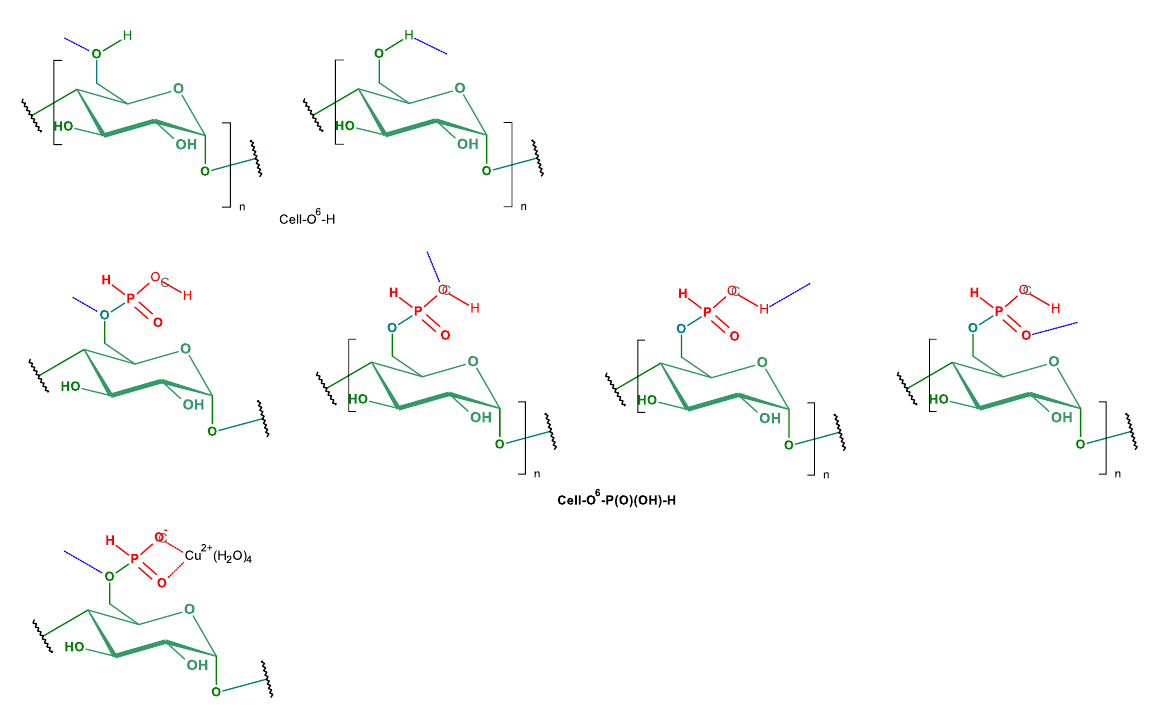
Figure 16. The ability for the formation of hydrogen bonds by 6-hydroxyl of cellulose (Cell- O 6 -H), cellulose-6-hydrogenphosphate (Cell- O 6 -P(O)(OH)-H) and cellulose-6-hydrogenphosphate-cooper (II) complex (Cell- O 6 -P(O)(OH)-H × Cu 2+ ). Dotted lines in blue present possible hydrogen bonds with appropriate acceptors/donors.